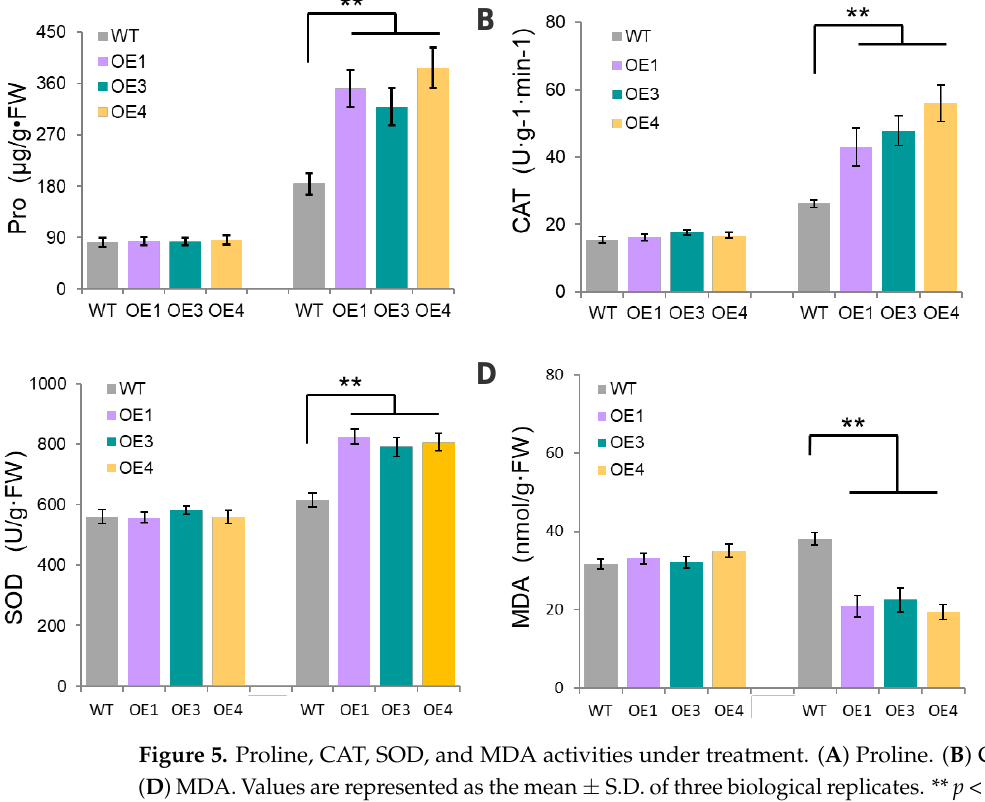
Figure 5. Proline, CAT, SOD, and MDA activities under treatment. ( A ) Proline. ( B ) CAT. ( C ) SOD. ( D ) MDA. Values are represented as the mean ± S.D. of three biological replicates. ** p < 0.01 Student’s t